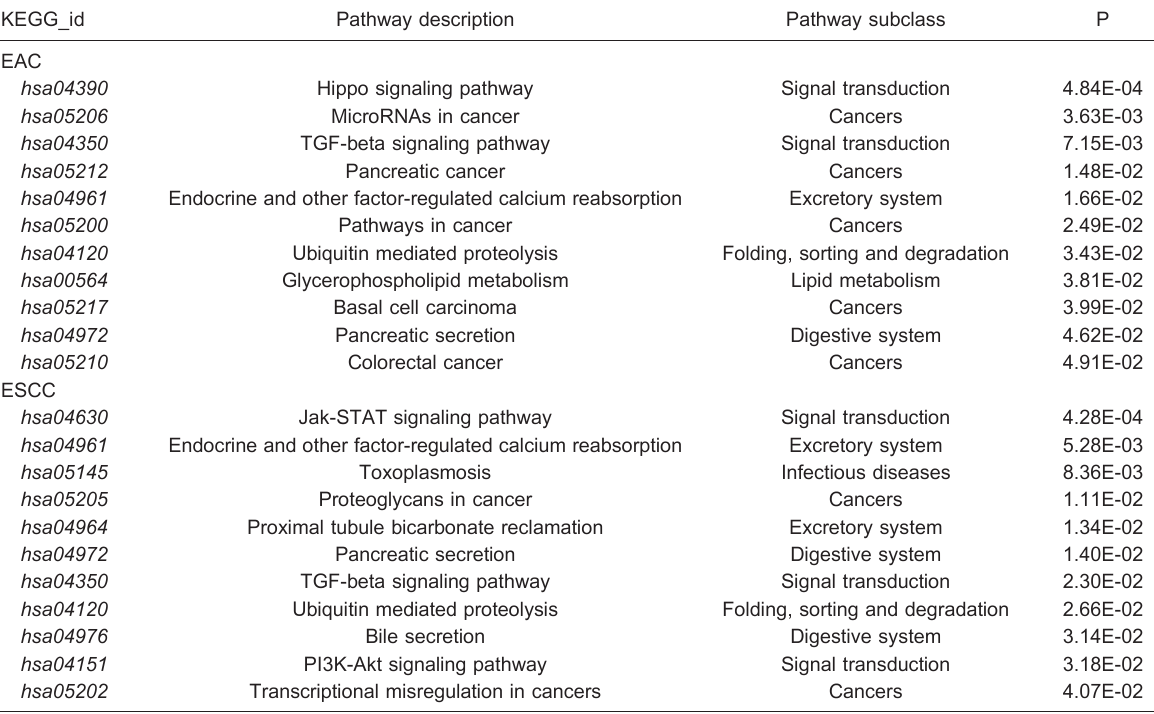
Table 2. KEGG pathway enrichment analysis for the differentially expressed target genes of selected miRNAs in esophageal adenocarcinoma (EAC) and squamous-cell carcinoma (ESCC).